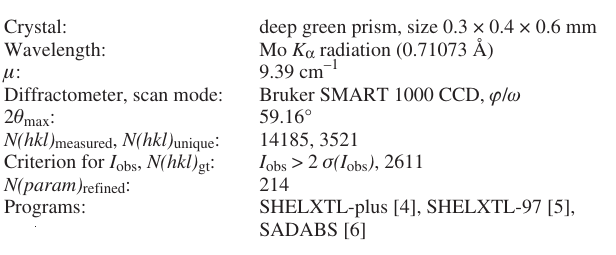
Table 1. Data collection and